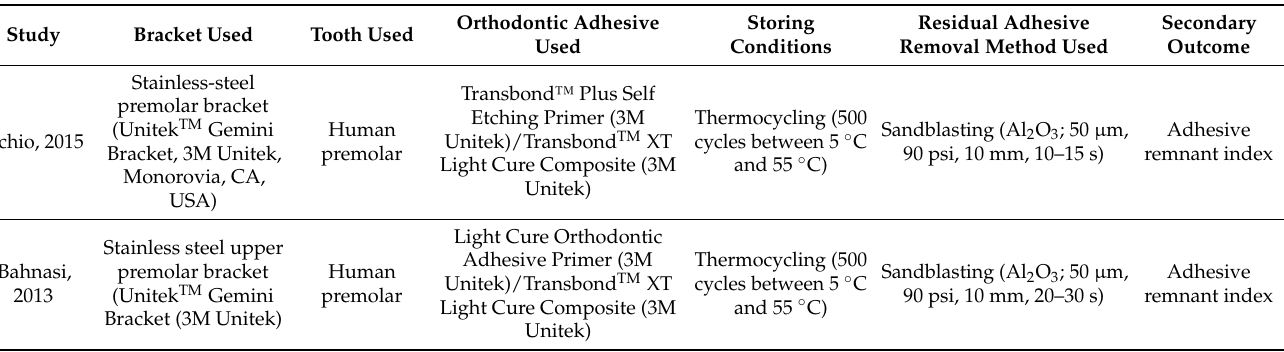
Table 2. Demographic data of included